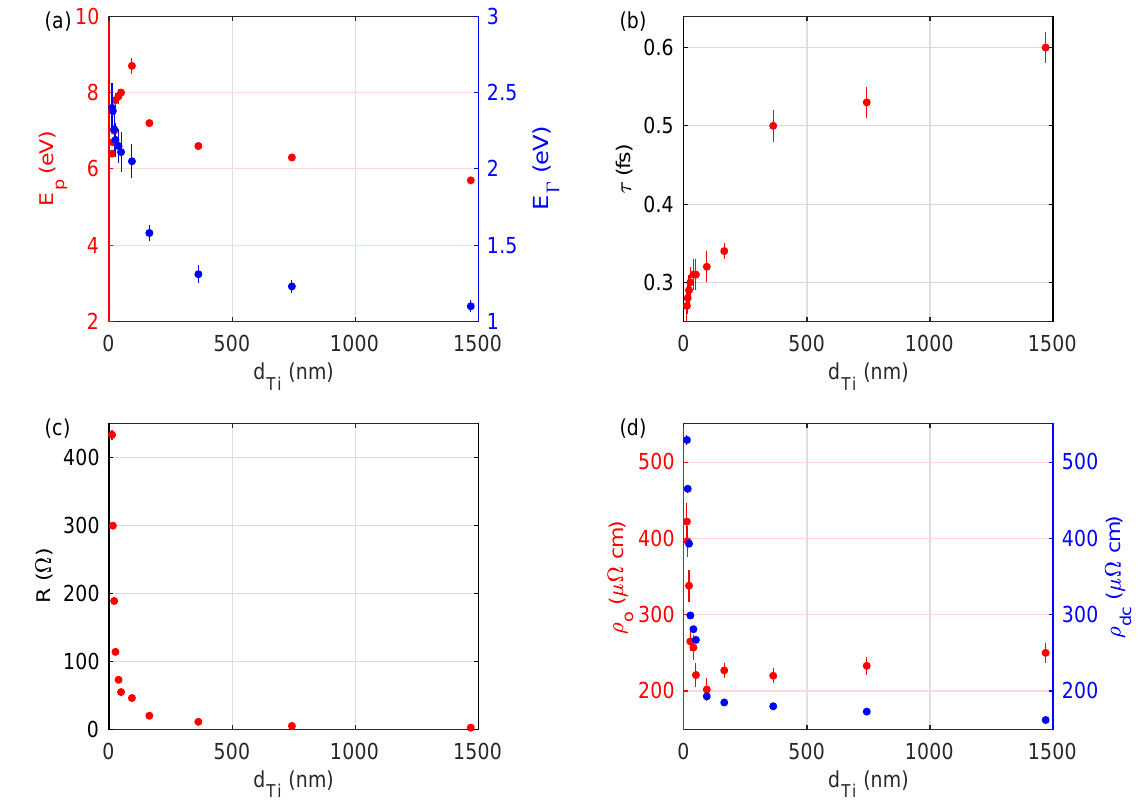
Figure 5. ( a ) The plasma energy ( E p = ¯ h ω p ) and the free-carrier dumping ( E Γ = ¯ h Γ ), ( b ) the mean relaxation time of conduction electrons ( τ ), ( c ) the sheet resistance ( R ), and ( d ) the optical ( ρ o ) and dc-resistivity ( ρ dc ) determined for the examined Ti coatings plotted as a function of the thickness of the Ti